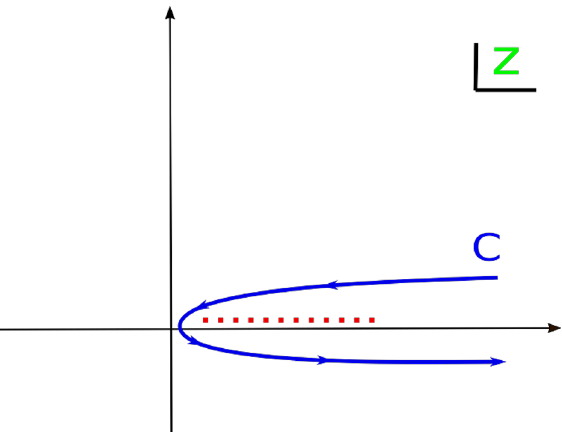
Figure 1 . The contour C of the integral (2.3)(blue line). Red dots are the poles of the meromorphic function f ( z ) = tr 1 . These poles are in the segment 0 < Re z < z (cid:0) (cid:26)